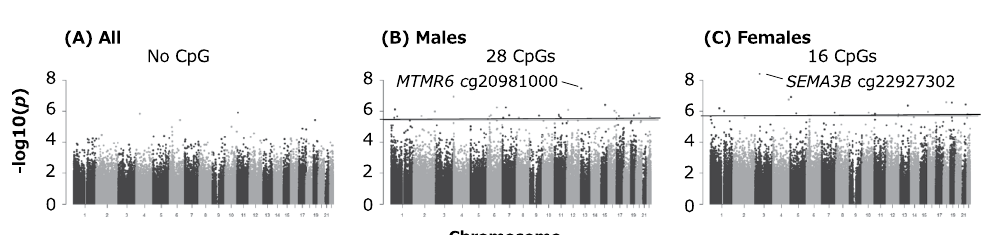
Figure 1. ( A ) Volcano plots of the log 10 ( p -values) versus the magnitude of effect (Coef) for the genome-wide analysis of the association between BPA exposure and DNA methylation in cord blood among all newborns, male infants, and female infants. Horizontal lines represent a p -value < 0.0001. ( B ) The percentage of hypo and hypermethylated CpGs with p < 0.0001 found in the analyses for all, male, and female infants.